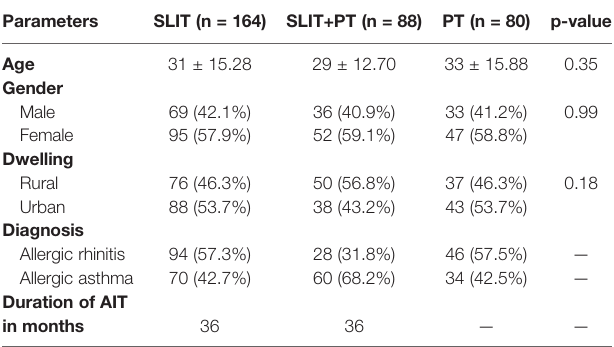
TABLE 1 | Demographic features of allergic patients. Parameters